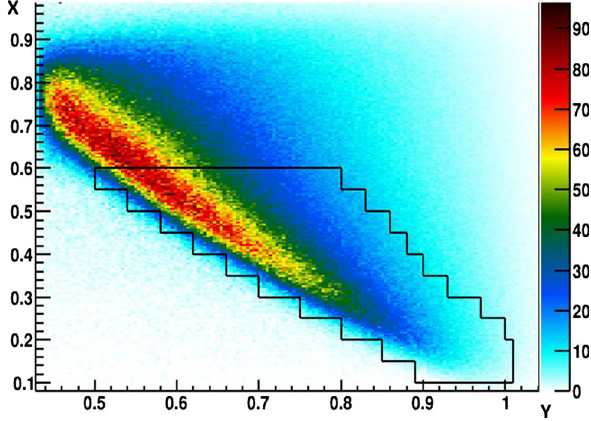
Fig. 5 INT − Dalitz-plot density and selected kinematic region (area contoured by the black line)